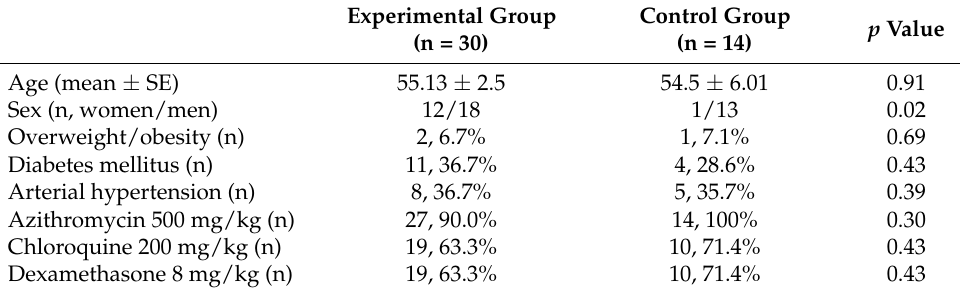
Table 1. Clinical and demographic data of the